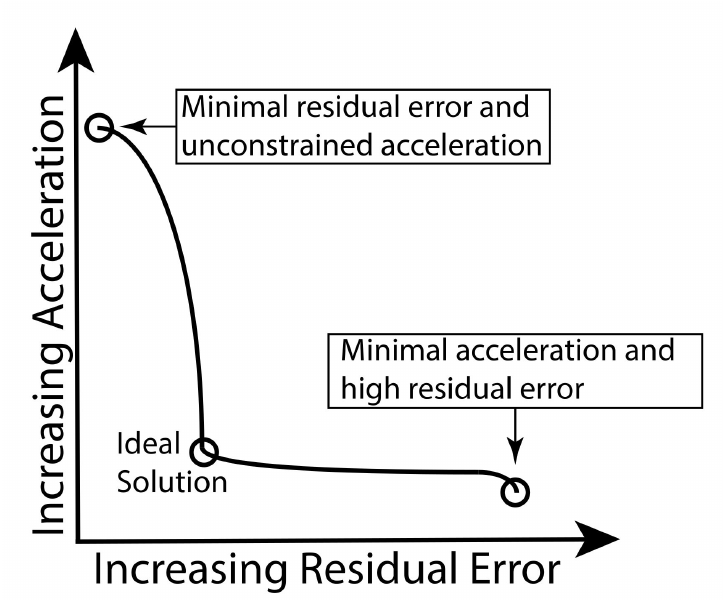
Figure 5. Example L-curve showing range of possible